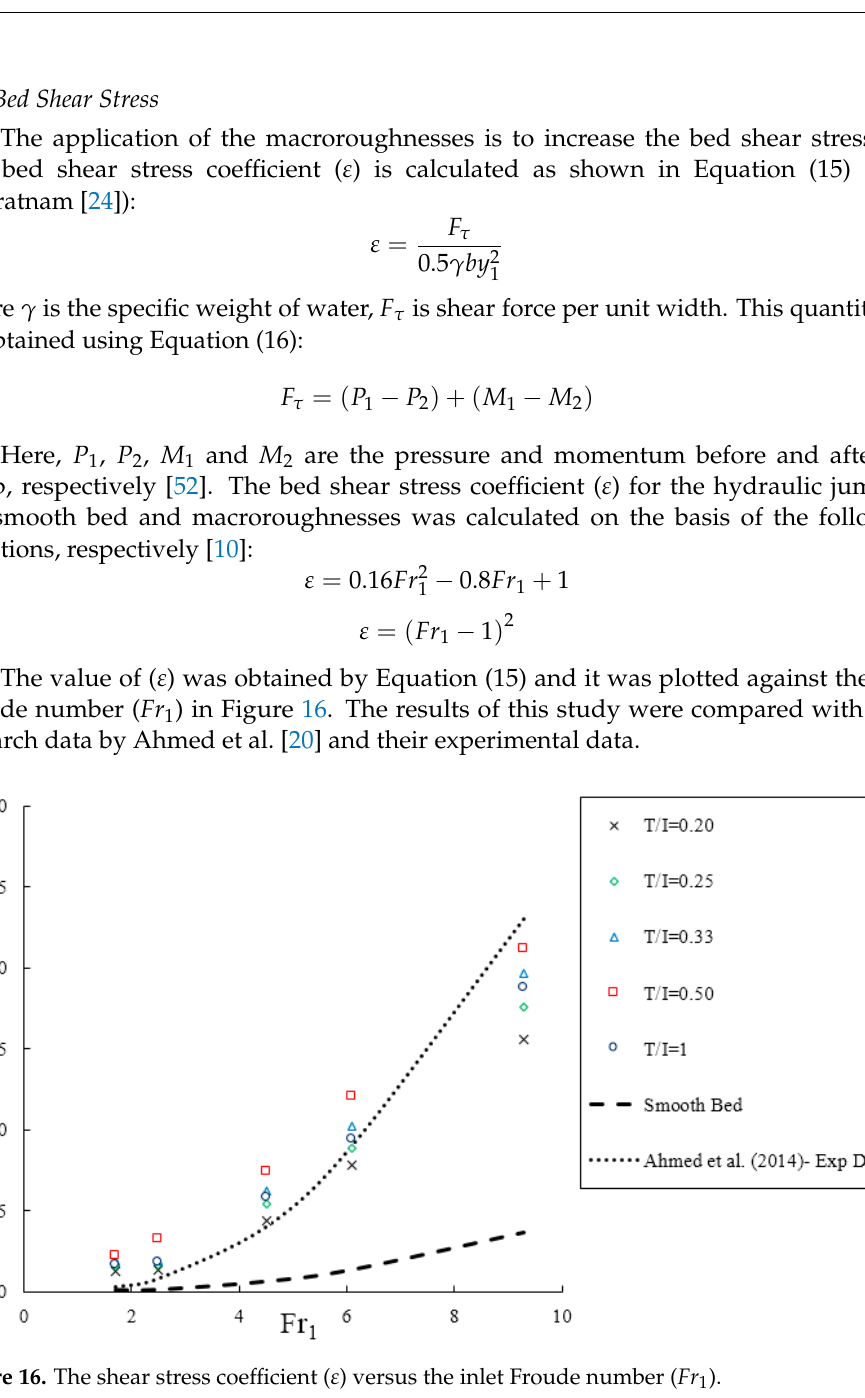
Figure 16. The shear stress coefficient ( ε ) versus the inlet Froude number ( Fr 1